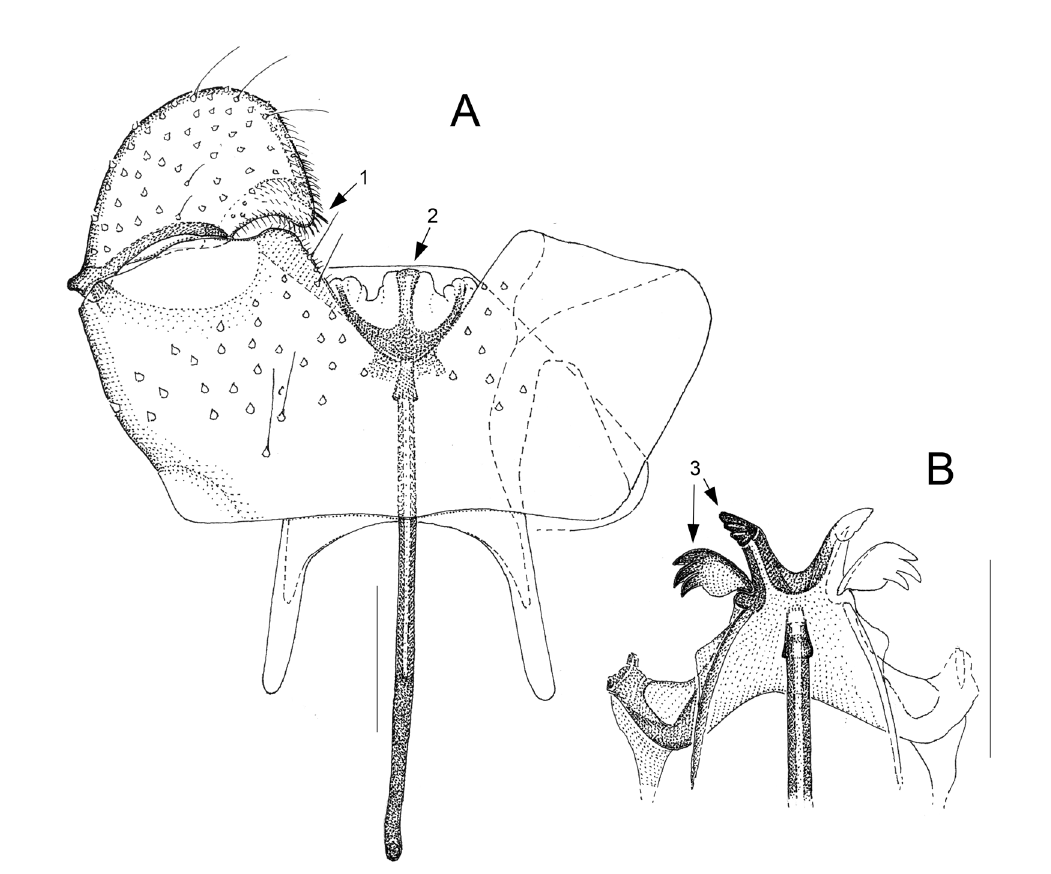
Fig. 12. Glemparon pureora sp. nov., holotype, ♂ (NZAC, no. CEC1424). A . Genitalia, ventral. B . Apex of ejaculatory apodeme and tegmen, ventral. Scale bars = 0.05 mm. Numbered arrows indicate diagnostic characters (see